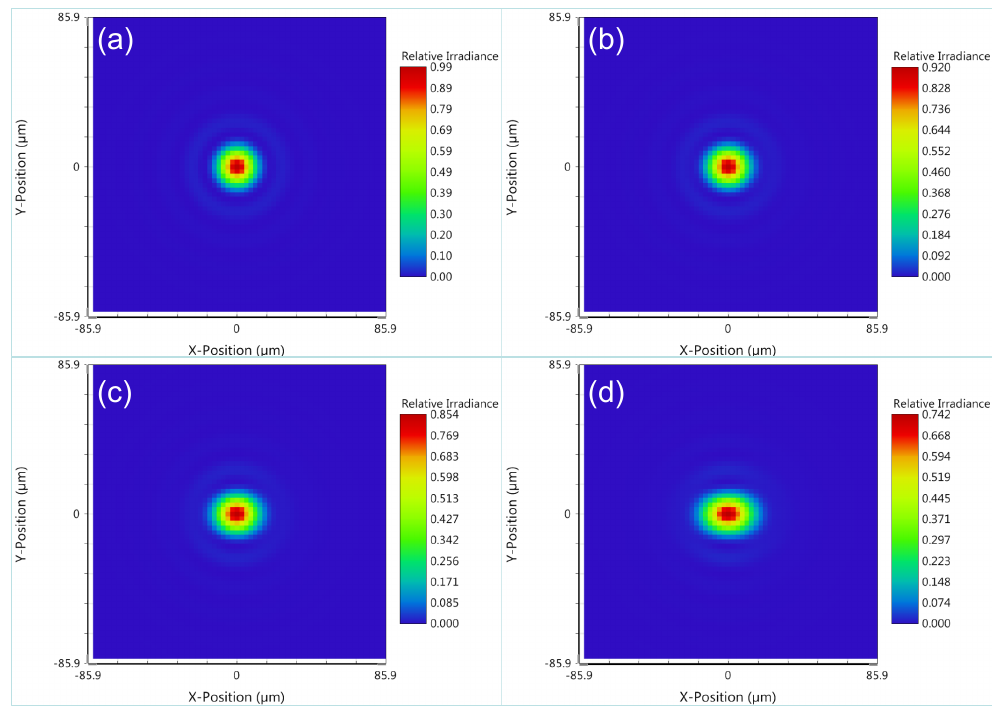
Figure 11. Zemax model of the BA1 amplifier with one of each of the following wedged crystals: Focal spot (polychromatic PSF) after an f = 1-m perfect lens. ( a ) Wedge = 0.2°, ( b ) wedge = 0.5°, ( c ) wedge = 0.7°, ( d ) wedge = 1.0°.